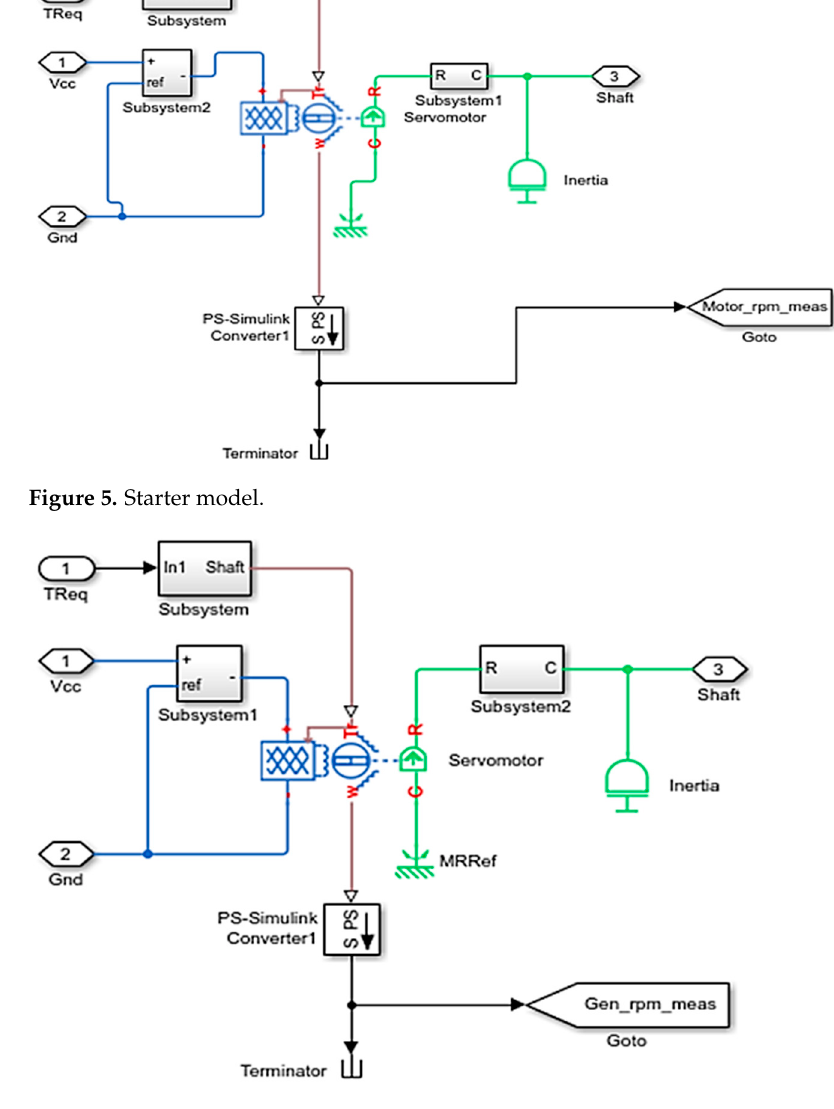
Figure 6. Generator model .